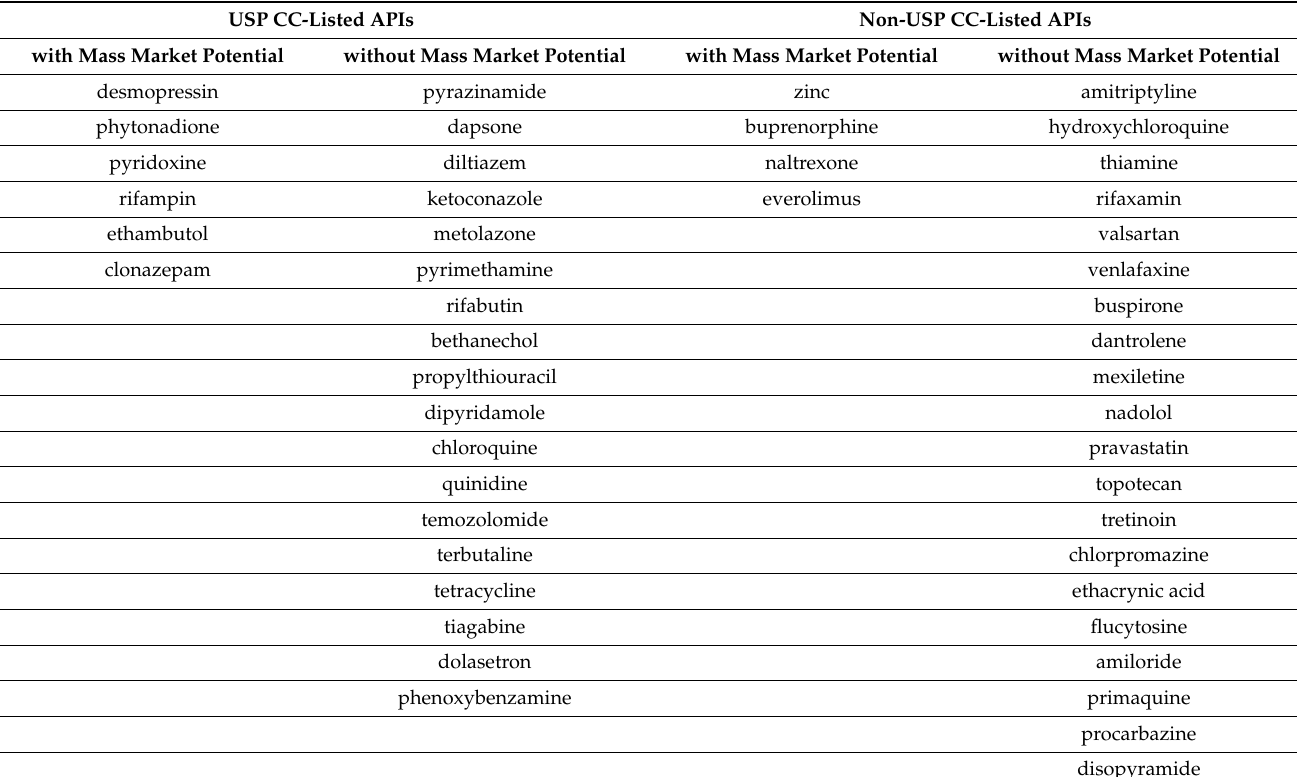
Table 7. APIs with potential for development as manufactured products or compounded